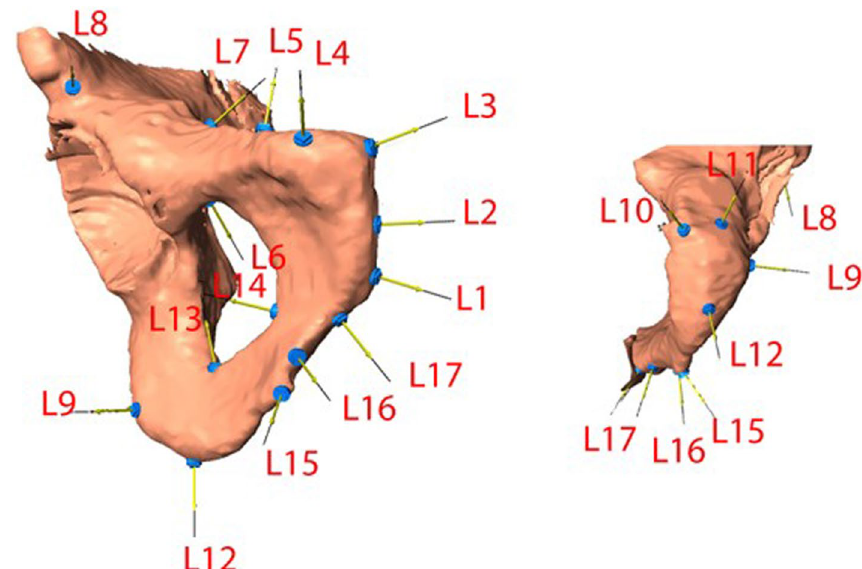
Fig. 1 The anterior view (left) and the inferior view (right) of the digitised landmarks on part of the innominate bone representing the Phenice method